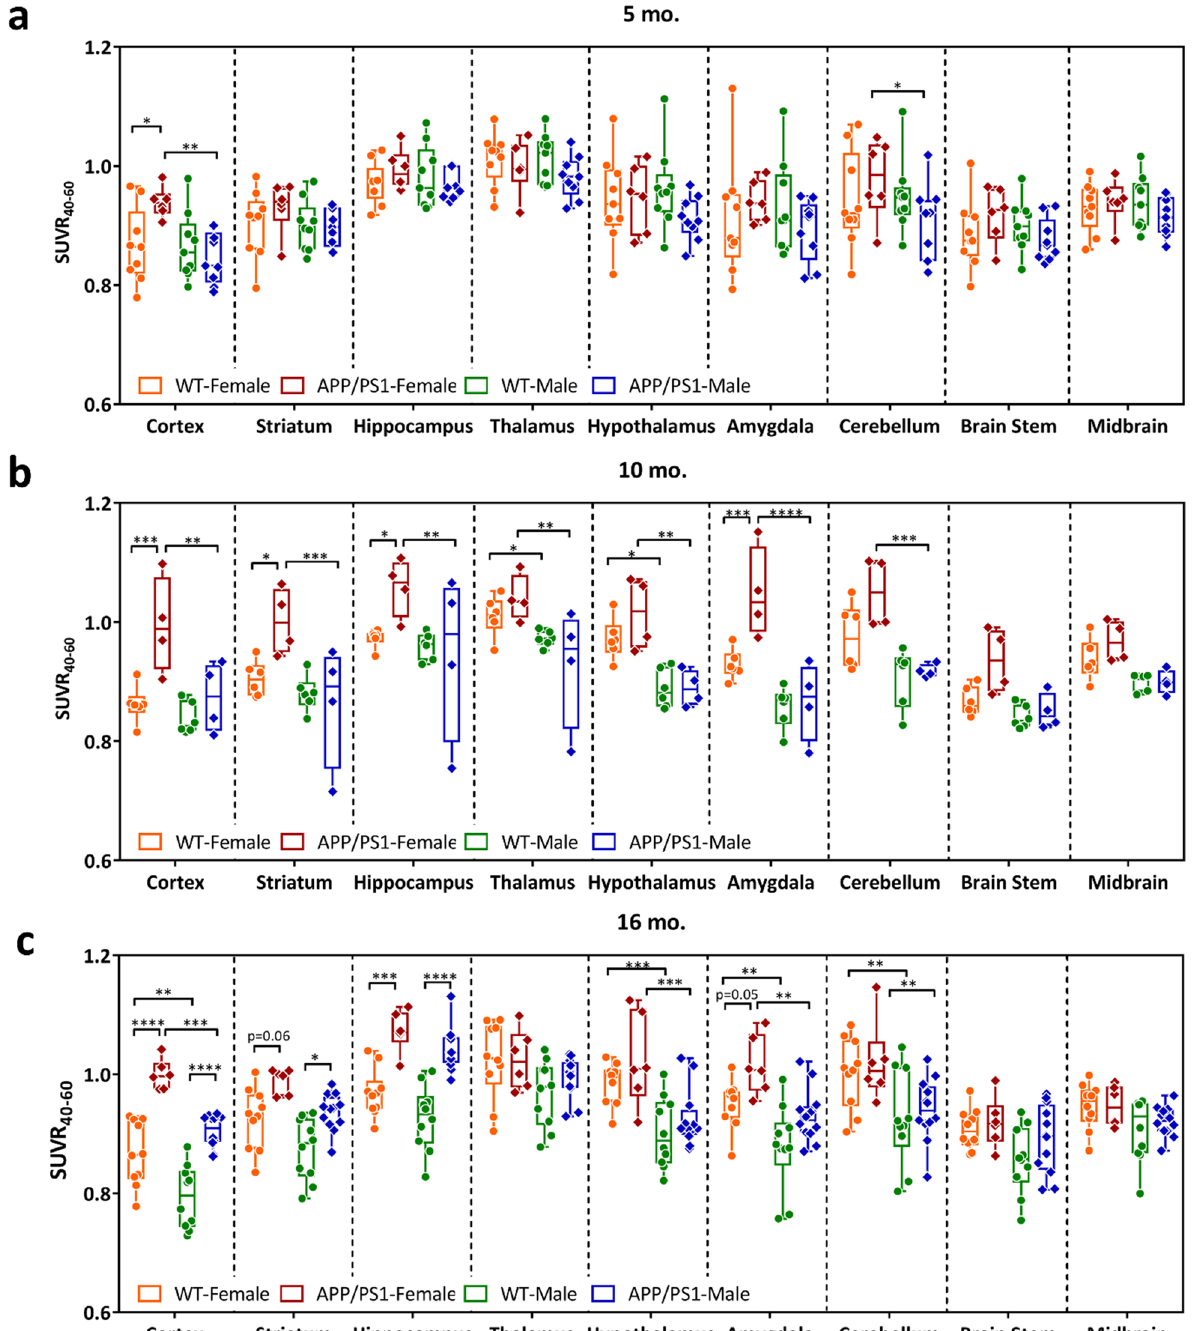
Fig. 2 Regional differences in [ 18 F]ROStrace uptake from 9 VOIs presented as standard uptake value ratios from 40–60 min post‑injection (SUVR 40‑60 ) in WT and APP/PS1 mice at a 5 mo. old: APP/PS1 group: n 6 for female, and n 9 for male; WT group: n 9 per gender, b 10 mo. old: APP/PS1 = = = group: n 4 per gender; WT group: n 6 per gender, and c 16 mo. old: APP/PS1 group: n 6 for female, and n 12 for male; WT group: n 10 per = = = = = gender. The statistical significance of p value calculated by two‑way ANOVA (* p < 0.05, ** p < 0.01, *** p < 0.001, **** p <